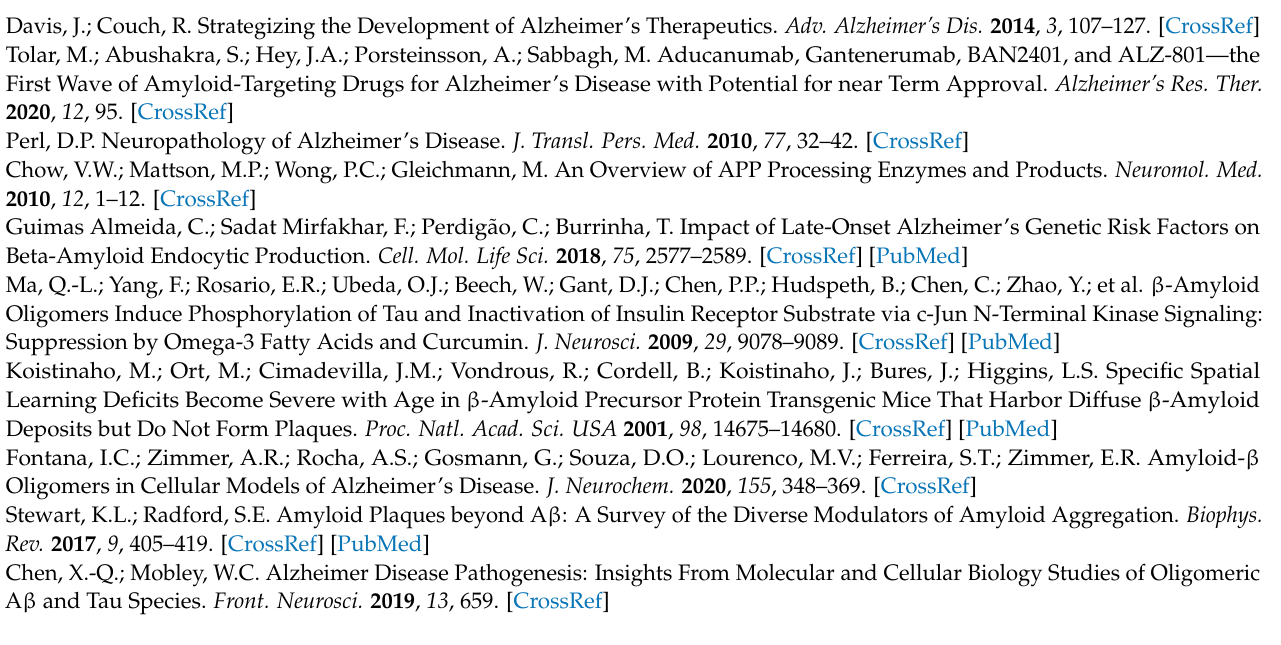
A β 42 treatment, Table S2: All proteins significantly increased by A β 42 treatment, Table S3: Membrane proteins significantly decreased by A β 42 treatment, Table S4: Membrane proteins significantly Table S6: Mitochondrial proteins significantly decreased by A β 42 treatment, Table S7: Mitochondrial proteins significantly increased by A β 42 treatment, Table S8: Nuclear proteins significantly decreased by A β 42 treatment, Table S9: Nuclear proteins significantly increased by A β 42 treatment, Table S10: Genomic Enrichment Analysis Results, Table S11: ER proteins significantly decreased by A β 42 treatment, Table S12: ER proteins significantly decreased by A β 42 treatment. The full dataset is available at